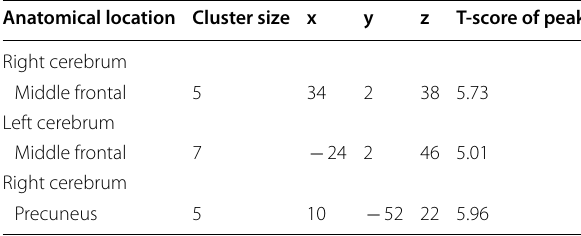
Table 3 Additional HC patient clusters identified with SQA using conventional controls as opposed to SQA using digital controls (anatomical locations, spatial extent of significant clusters in cm 3 , MNI coordinates, maximal T-scores of the peak voxel) at a T-voxel threshold of 3.3, k